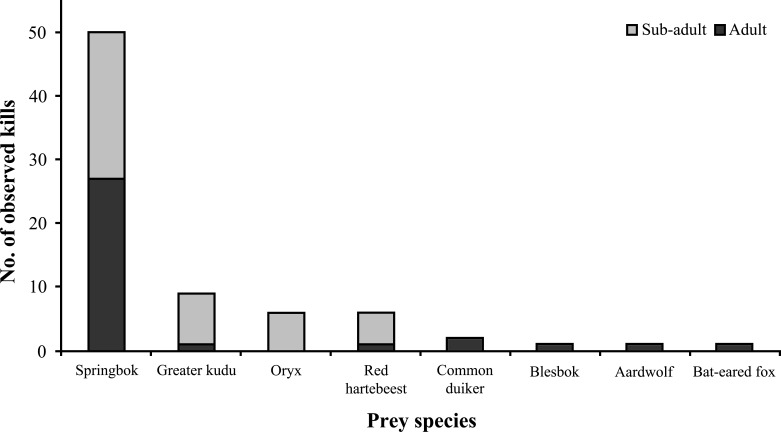
Documented wildlife prey of translocated cheetahs.Kills (n = 76) represent direct observations and carcasses located through VHF/GPS telemetry.